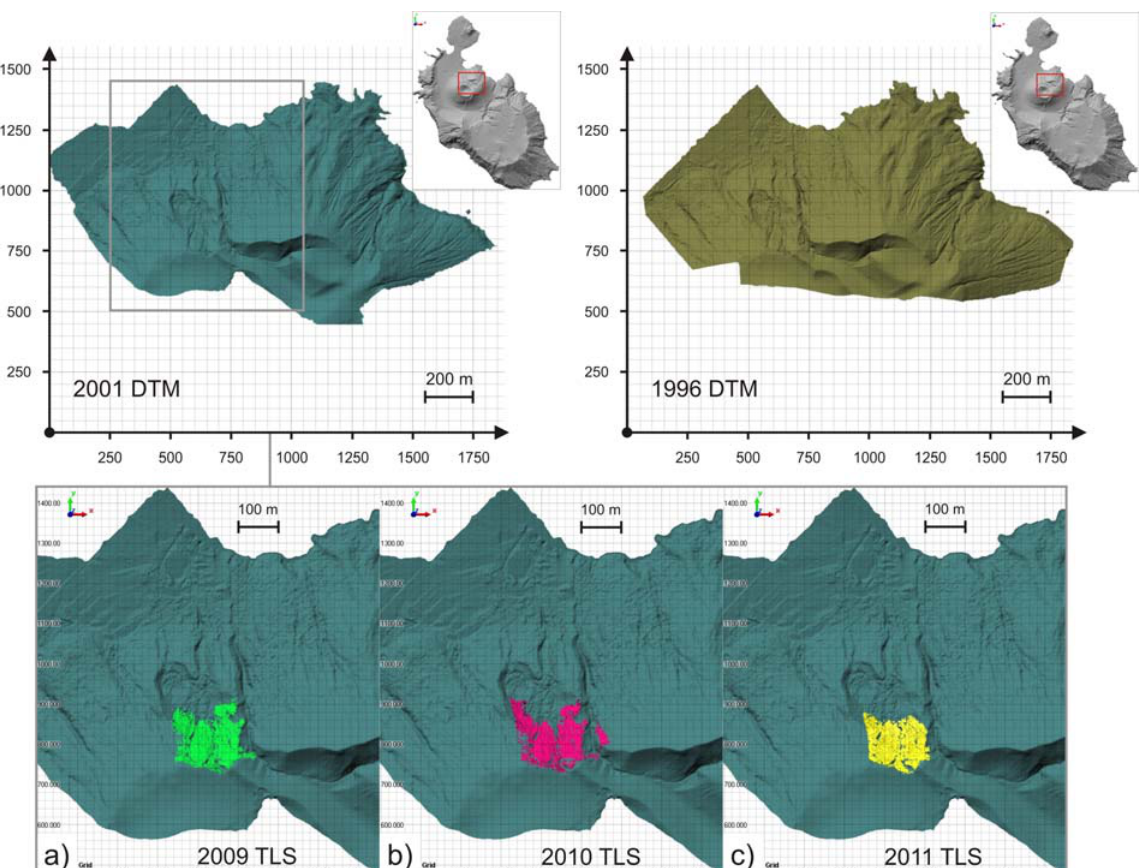
Figure 3. ( Upper ) panels: digital terrain models (DTMs) obtained by photogrammetric data taken in 1996 and 2001 measurement campaigns. The grid sizes of the DTMs are 10 m for the entire island and 1 m for the La Fossa cone area. ( Lower ) panels: areas acquired by TLS in 2009, 2010 and 2011 overlapped to the 2001